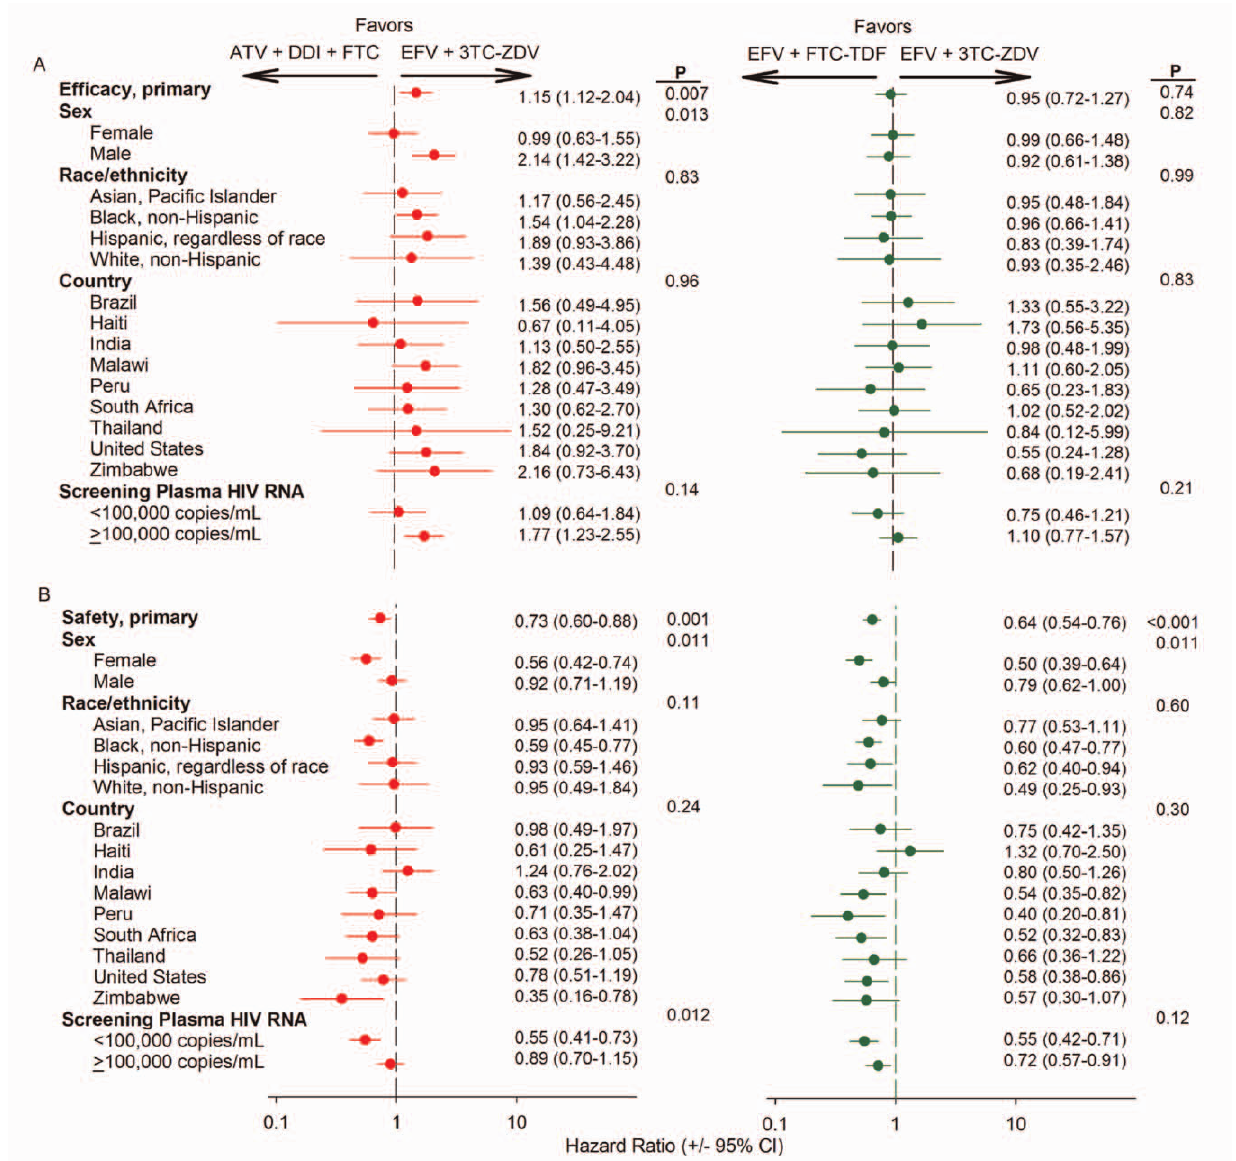
stratum (Figure 3A, right side). The most common cause of regimen failure was confirmed plasma HIV-1 RNA $ 1,000 copies/ml (81% of all primary endpoints). The range of the relative risk difference for virologic failure was 0.72 to 1.36 (Table 2). Of 156 initial virologic failures, 64 (41%) and 125 (80%) occurred within the first 24 wk and 96 wk of follow-up, respectively. There were no significant differences in the risk of HIV-1 disease progression or death between arms. 25 disease